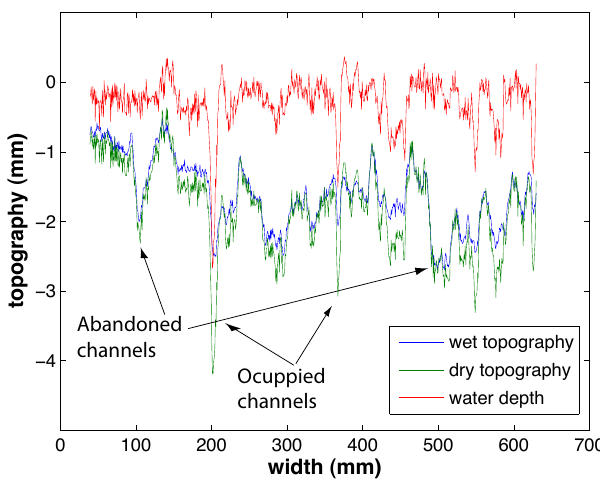
Fig. 7. Transects into wet, dry and water depth topographies at length value of 530mm.